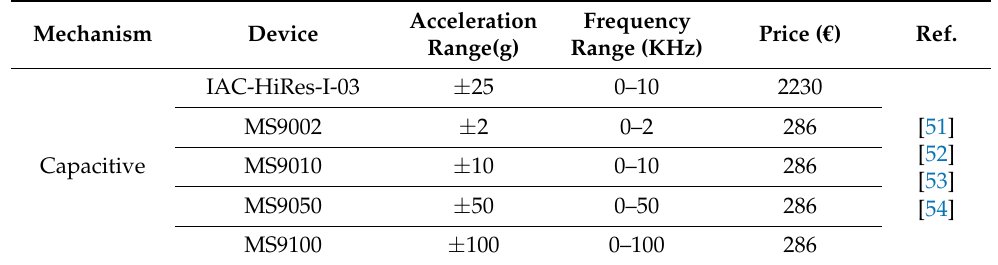
Table 2. Example of common accelerometers in the